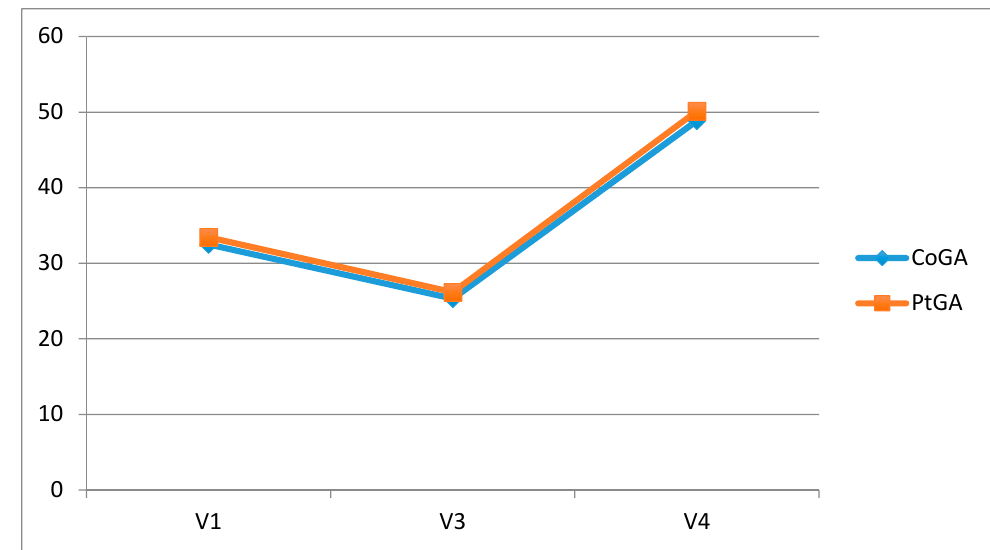
Figure 3. Statistically significant difference between baseline and 30 and 60 days follow-up of the Wilcoxon test. CoGA, Clinical Observer Global Assessment, PtGA, Patient’s Global Assessment.